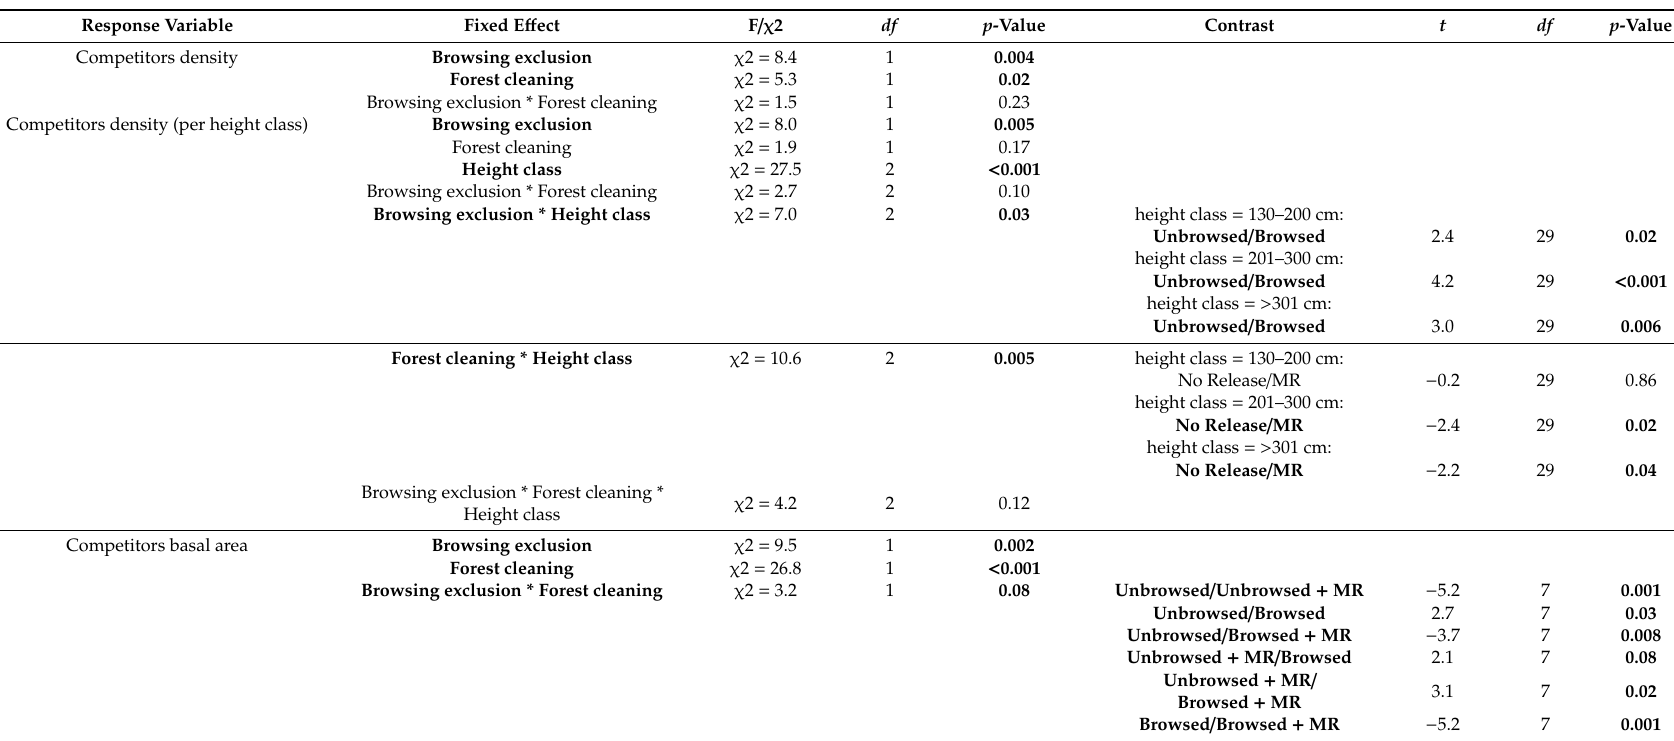
Table 1. Results of models analysing the e ff ects of browsing exclusion (unbrowsed / browsed) and forest cleaning (no release / mechanical release) on the competition and growth of the planted white spruces. “MR” stands for mechanical release. All the models included the forest cleaning treatment nested within the browsing exclusion treatment, nested within the site as a random factor. For competitor variables, we used general linear mixed models with a negative binomial distribution. For spruce variables, we used linear mixed e ff ects models with a gaussian distribution. Significant fixed e ff ects and contrasts are in bold. Asterisk (*) represent interaction between fixed e ff ects. We used α = 0.1 as a threshold for statistical